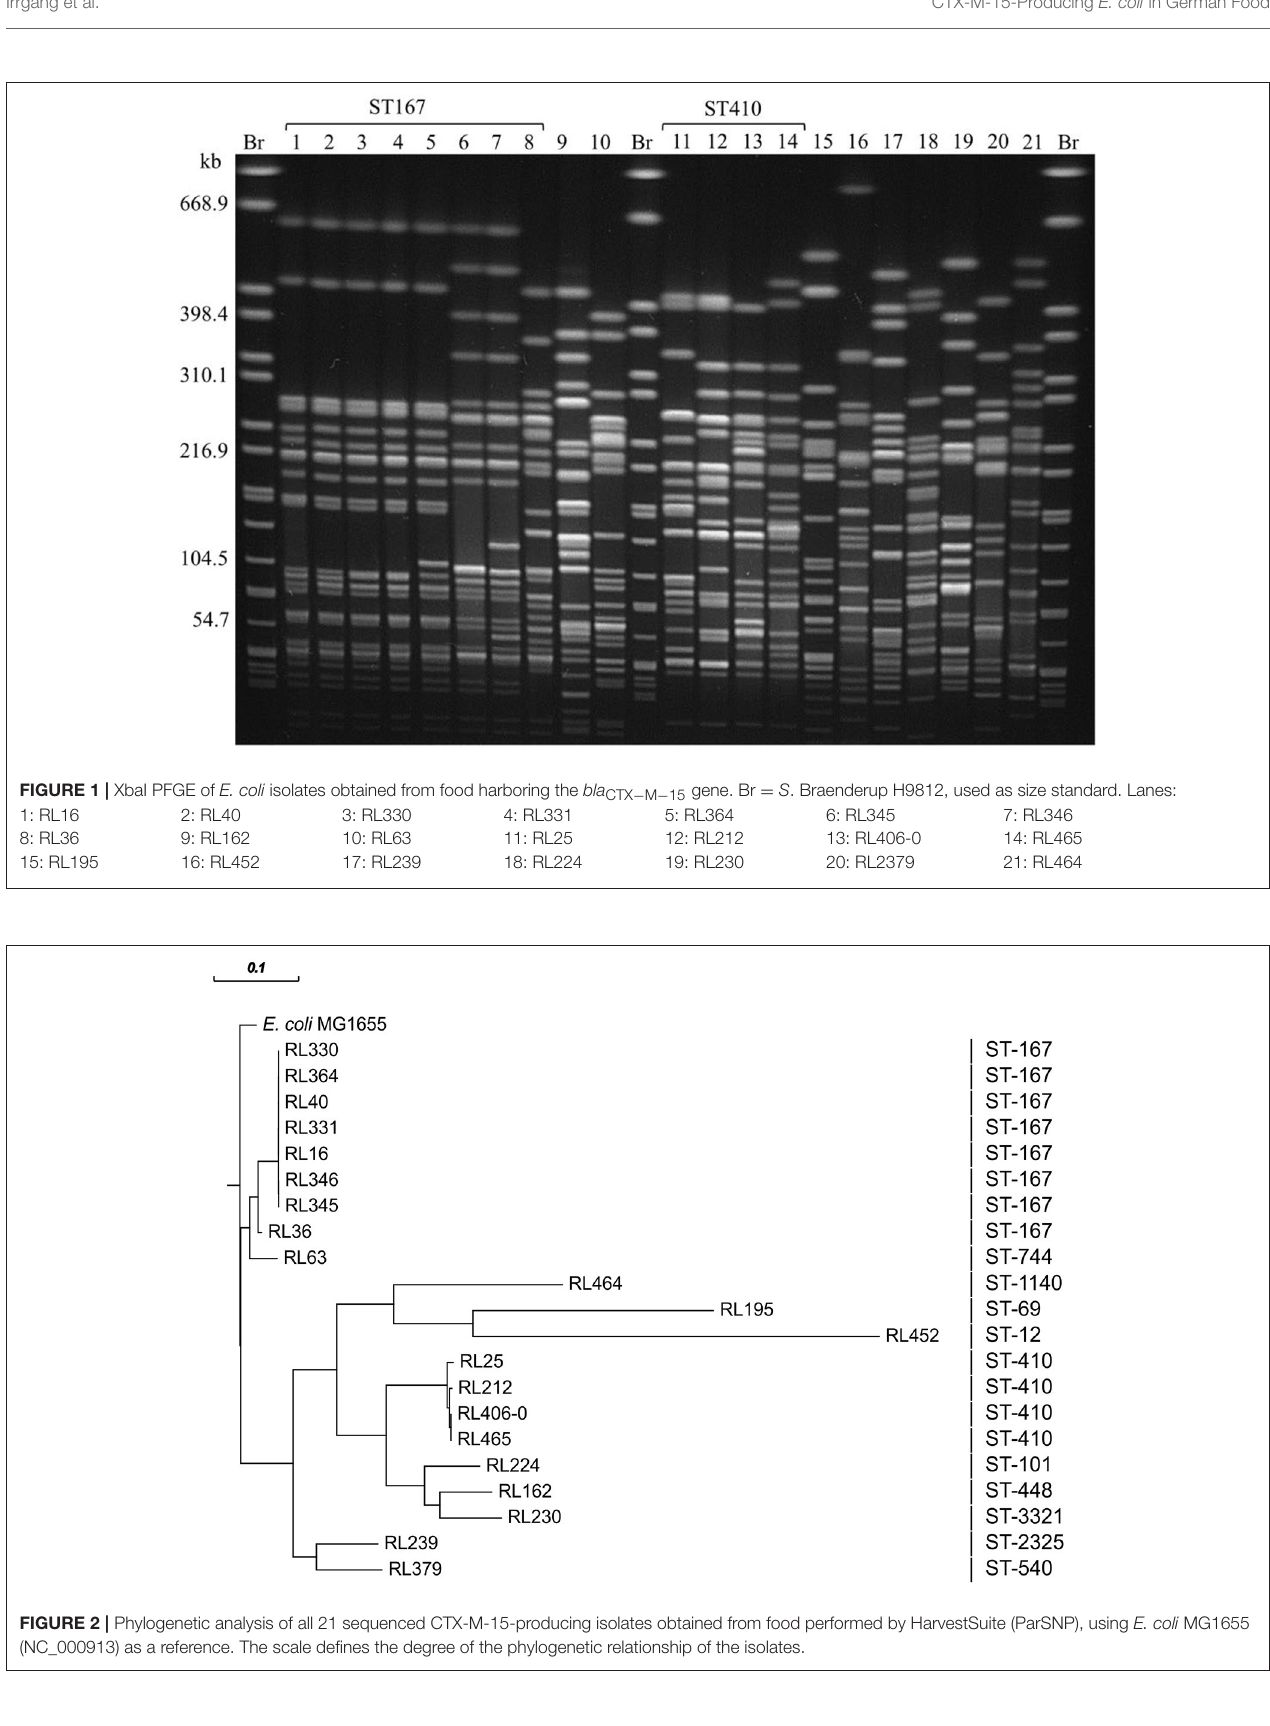
Frontiers in Microbiology |